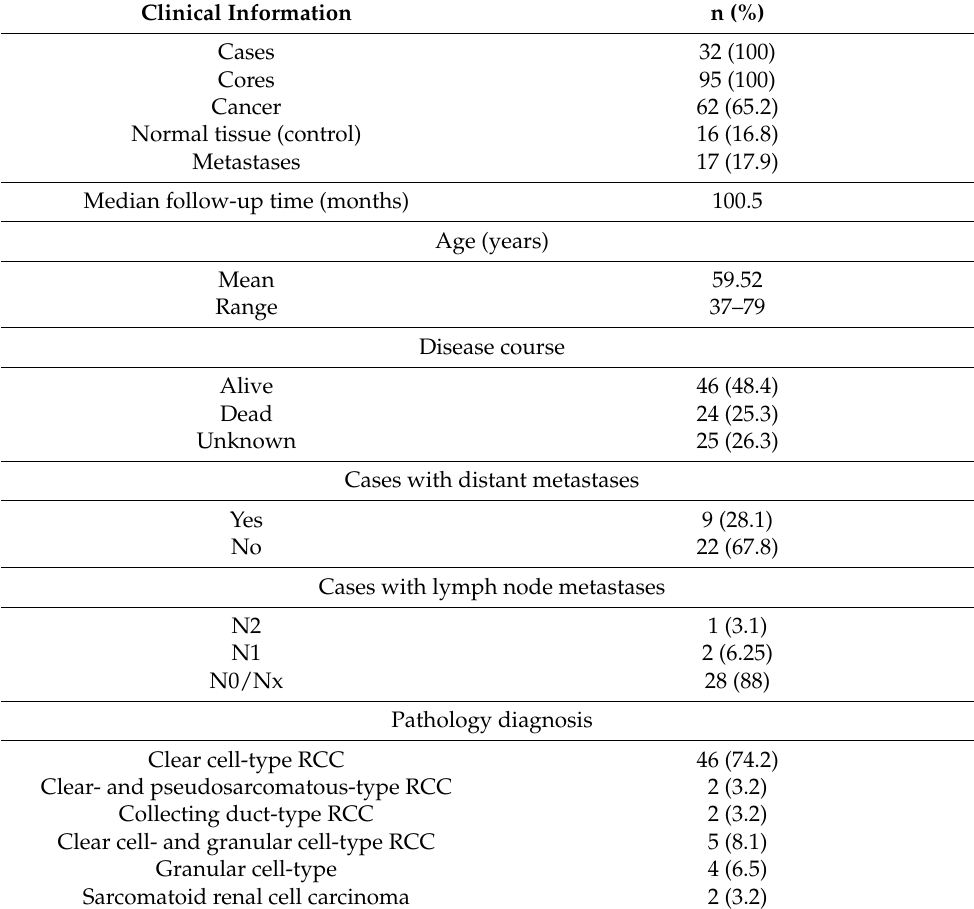
Table 1. Baseline characteristics of TMA (n = 32) patient